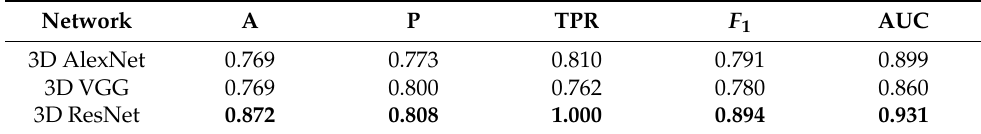
Table 2. Comparison of three different